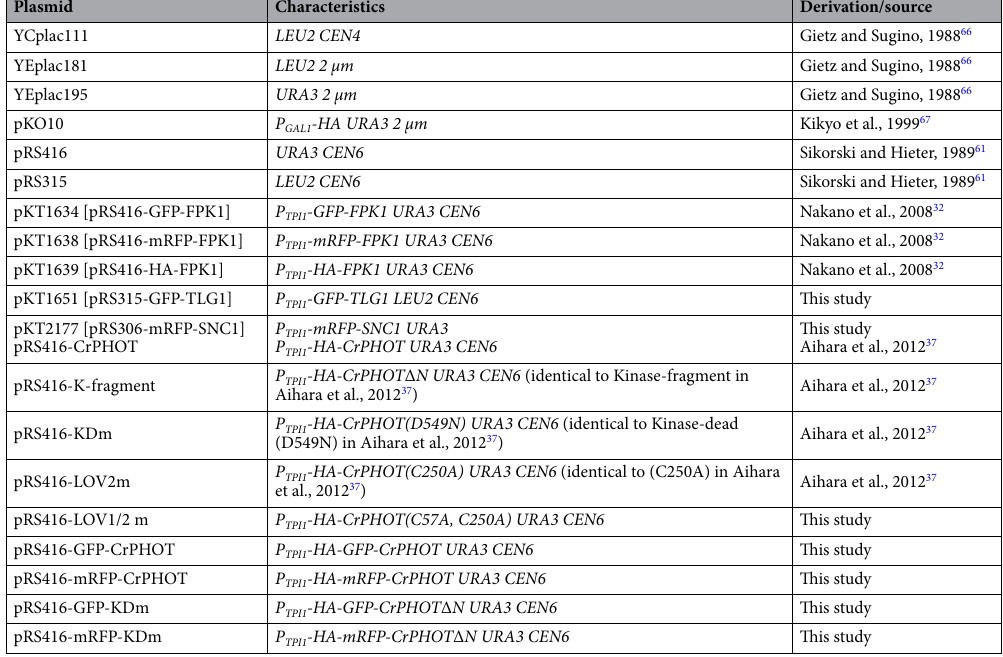
Table 2. Plasmids used in this